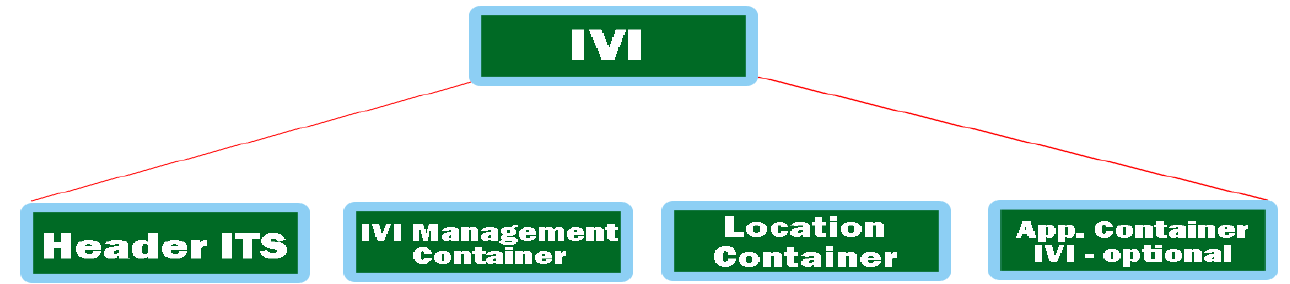
Figure 6. General structure of IVI messages.